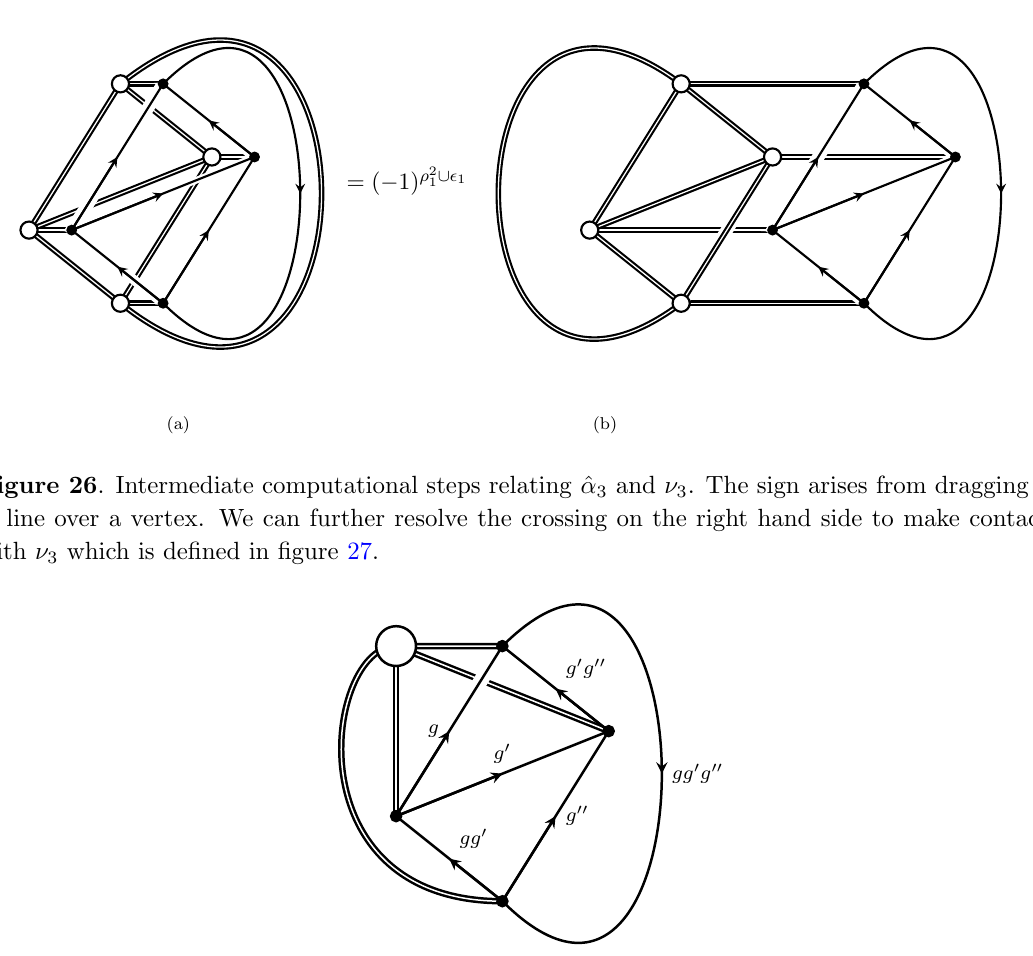
Figure 27 . The de(cid:12)nition of (cid:23) 3 ( g; g 0 ; g 00